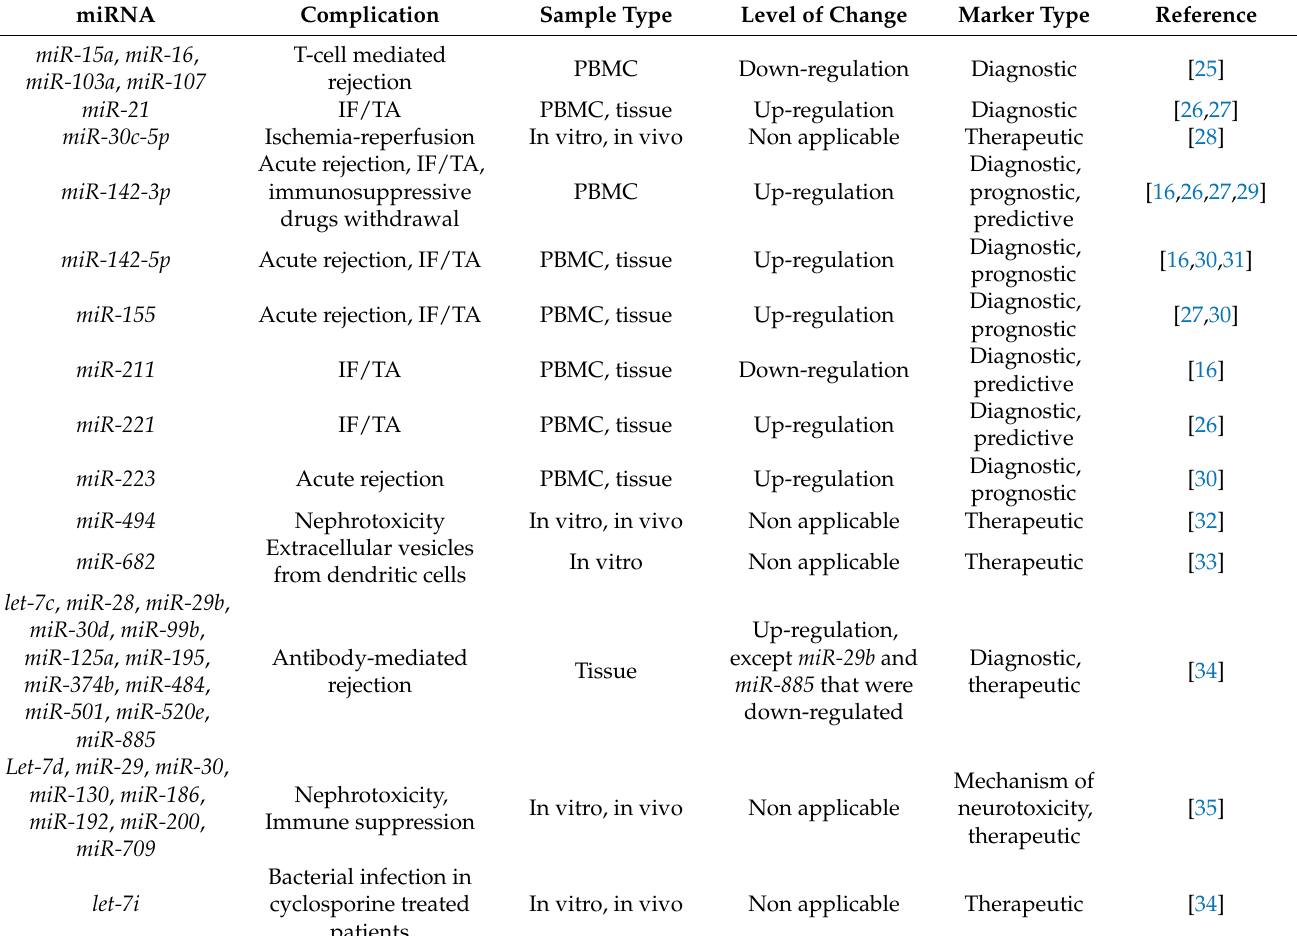
Table 1. Overview of human immune-related and differentially expressed miRNAs in complications after kidney transplan- tation 1